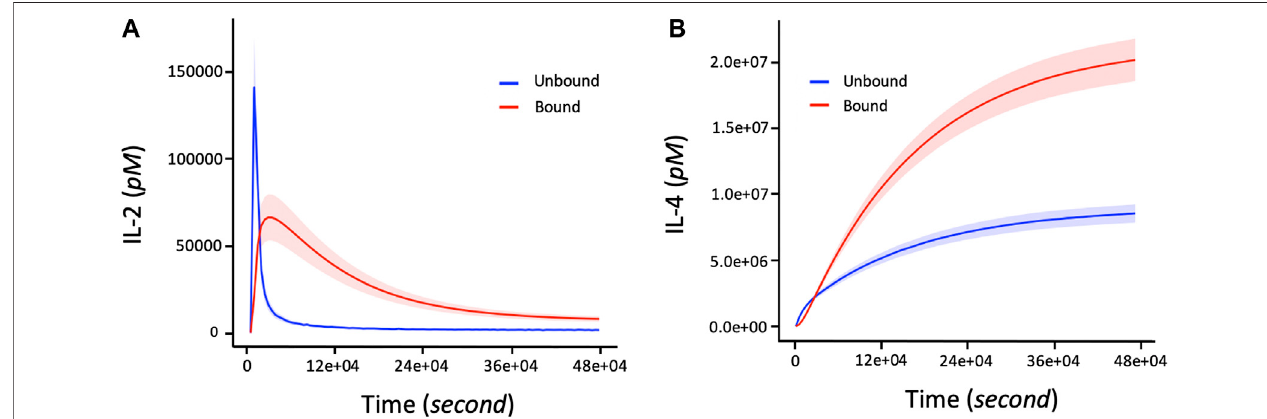
FIGURE3| ThenumberofboundedandunboundedIL-2andIL-4receptorsdrivingtheproliferationresponseofTcellsandBcellsintheimmunesystemovertime. The parameter values (in Eqs 2 – 5 ) used to obtain these curves are shown in Table 2 . The initial corresponding concentration of IL-2 and IL-4 used are respectively 1.5 and 15pM. (A) Non-linear pro fi le representing the dynamic changes of IL2 bounding to receptors. The bounded number of IL-2 correspond to the number of IL-2 involved in the proliferation of T cells and B cells during an immune response. (B) Increasing changes of the bounded number of IL-4 corresponds to the level of cytokine IL-4 connected to the activation and proliferation of B cells. The shaded areas of IL-2 and IL-4 represent the con fi dence intervals at 95% con fi dence level of parameter values of the